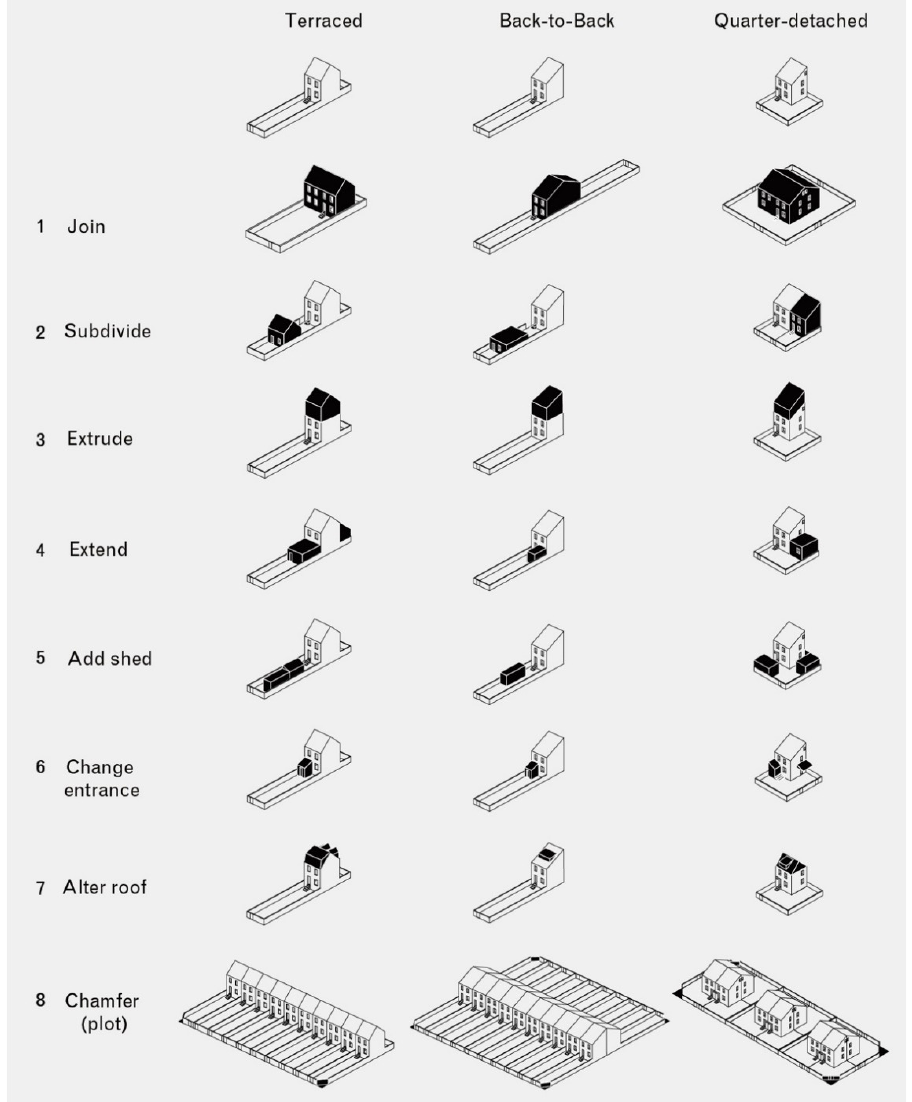
Figure 8. Types of exterior physical transformations found in the three main housing typologies of Cité Ouvrière in Mulhouse. Source: Kostourou (2020, p.